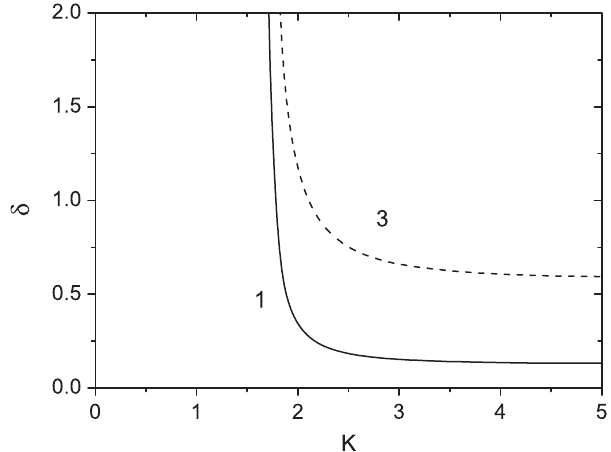
FIG. 3. Parameter (cid:4) for the retuned fundamental harmonic ( (cid:4) ð 1 Þ , solid line), and for the third harmonic ( (cid:4) ð 3 Þ , dashed line), versus rms undulator parameter. The gain lengths of the third harmonic and of the retuned fundamental harmonic are equal. Retuning is done by reducing undulator